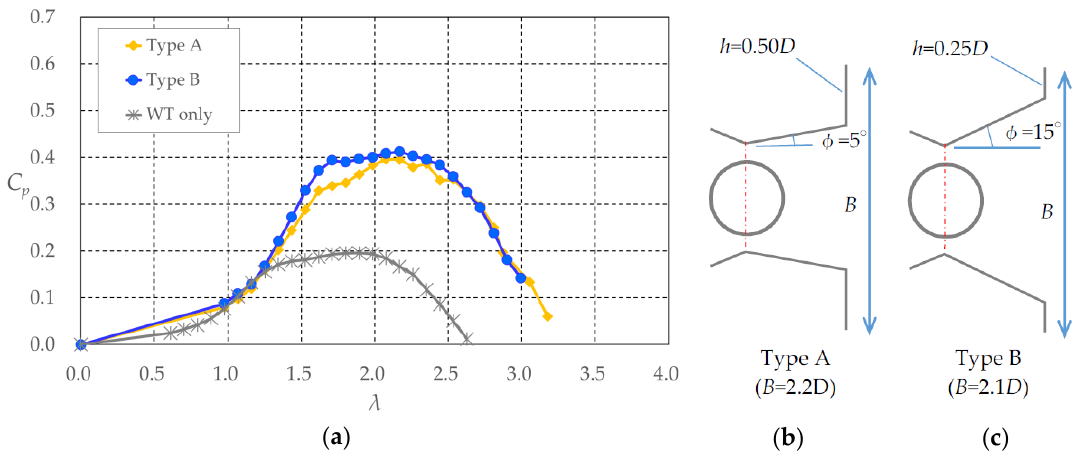
Figure 5. ( a ) Power coefficient C p of wind turbines with and without a wind lens vs. tip speed ratio λ (diffuser length: L = 1.14 D m); ( b ) plan view of the wind lens of type A; and ( c ) plan view of the wind lens of type B. Refer to Figure 2 for h , D , and L .